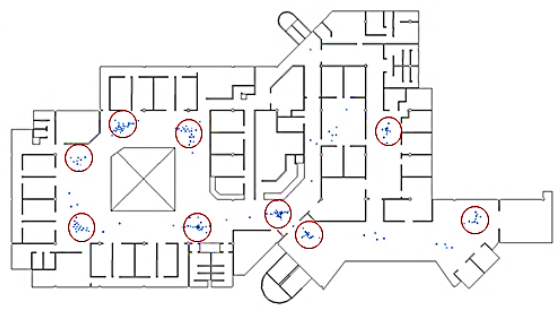
Figure 12. Illustration of the location of the pauses mapped on the building layout of the 2nd VRE.